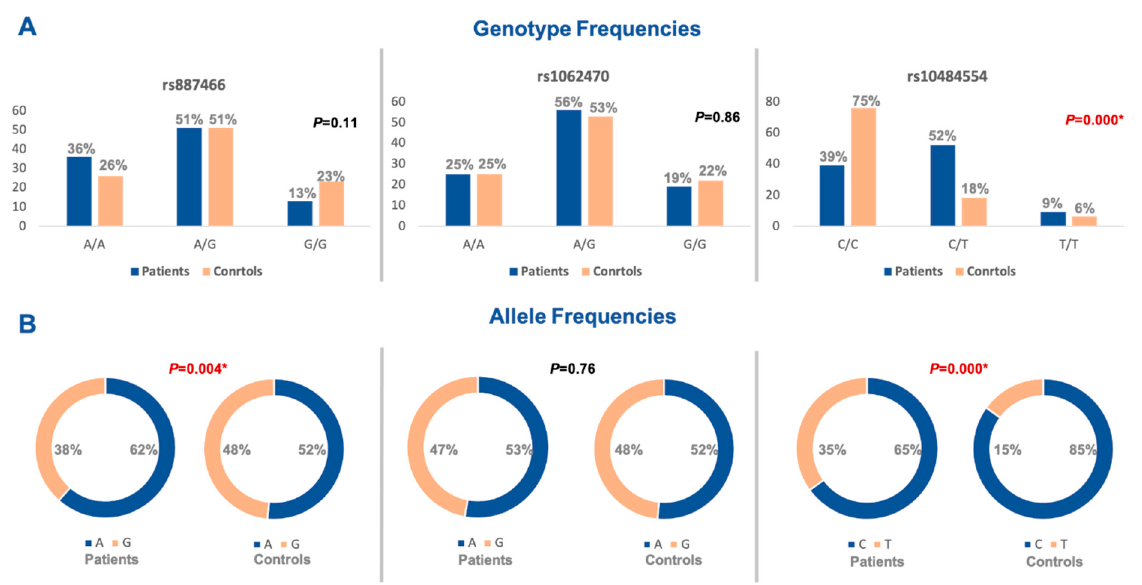
Figure 2. Genotype and allele frequencies of the studied genetic variants for the PSORS1C3 gene. ( A ) Genotype frequencies of polymorphisms. ( B ) Allele frequencies of polymorphisms. A Chi- square test was applied. Statistical significance was set at p < 0.05. Bold red values with * indicate significant value.